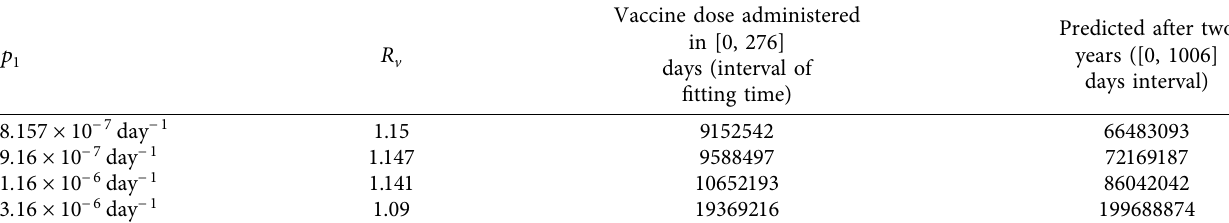
. Other parameter 1 1